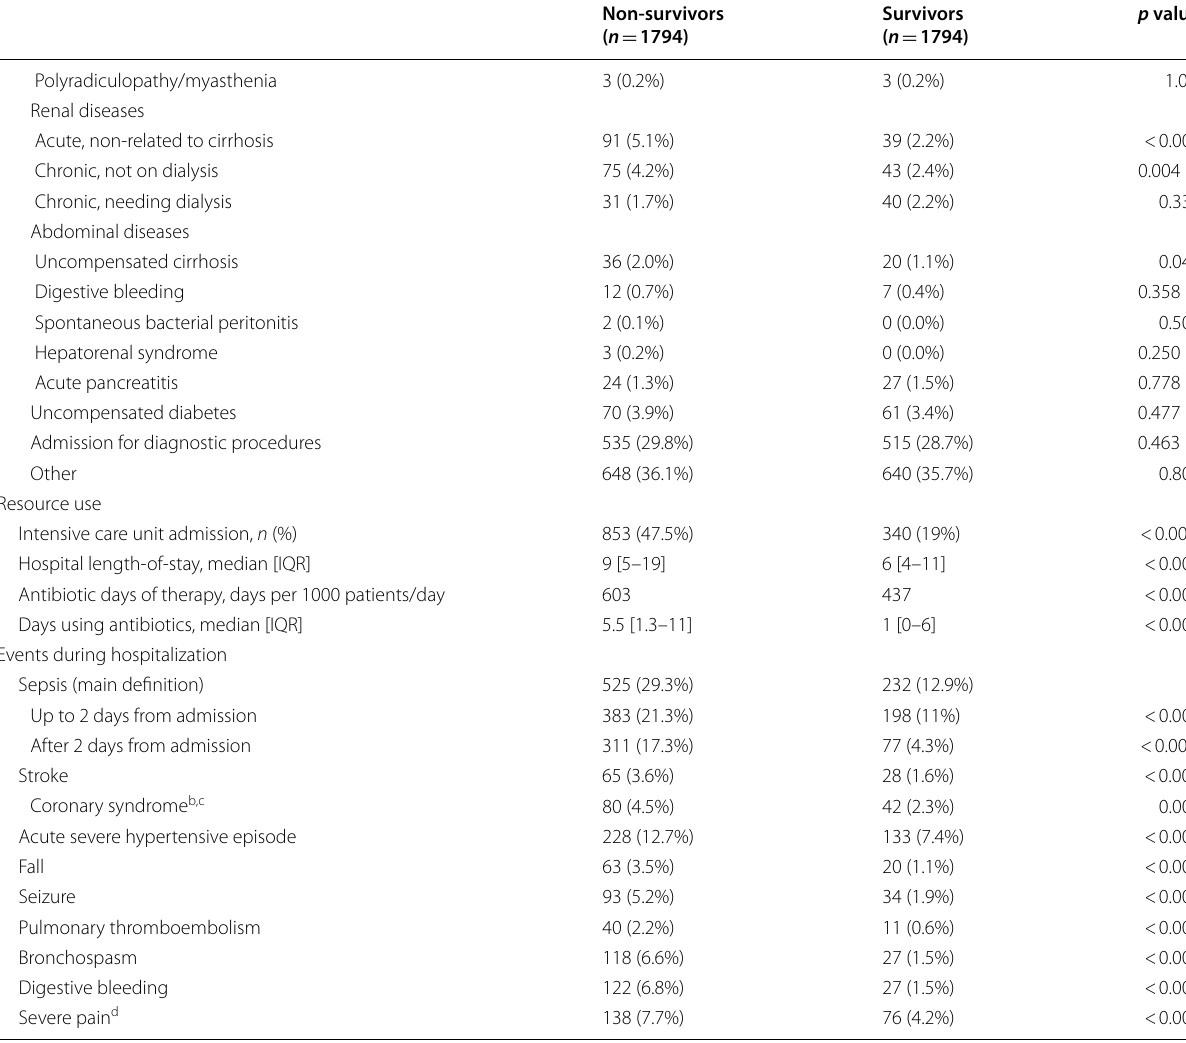
Additional file 1: Table S5 (74 patients with any positive